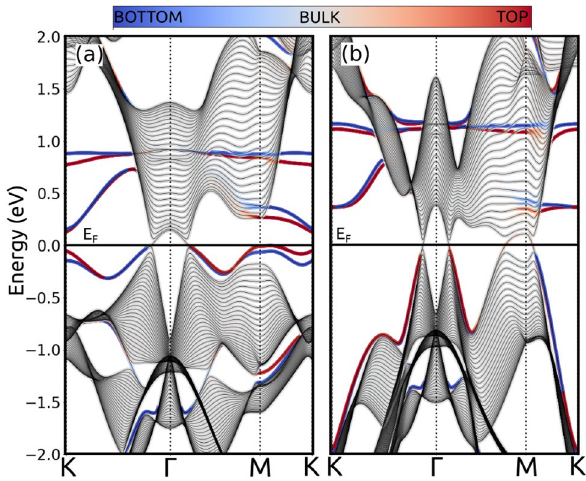
Figure 7. Energy states in a 50-layer structure stacked along the z-direction (Sn-dangling bond terminated). The colormap represents the expectation value of the position operator along the z-direction, in blue (red) the bottom (top) layer and in grey the bulk states. ( a ) For P = 0 (T1), the surface states fill the region outside the projected nodal line around the Ŵ point ( b ) For P = 6 GPa (T2), the surface states get opened around the M point due to the new nodal